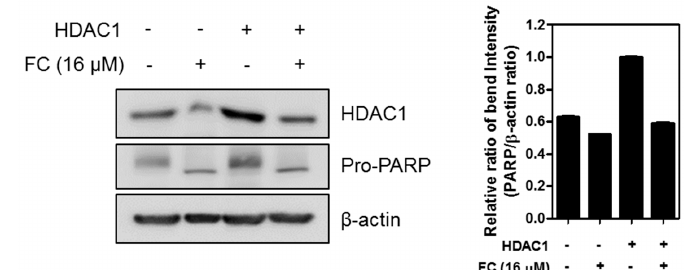
Figure 5. The role of HDAC1 in FC induced apoptosis in K562 cells. K562 cells were transfected with HDAC1 plasmids and treated with or without FC, respectively, and then subjected to Western blotting with antibodies of HDAC1 and PARP. β -actin was used as an internal control.